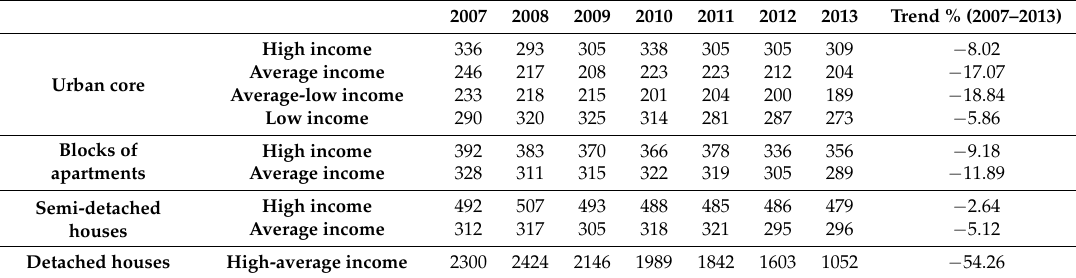
Table 2. Evolution of domestic water consumption by urban typology and economic rent in the city of Alicante (liters/house/day), 2007–2013. Source: AMAEM. Elaborated by the authors.